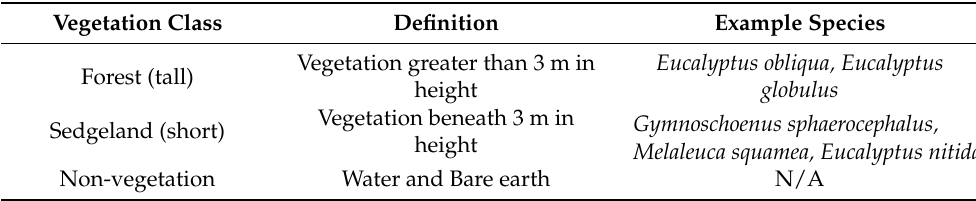
Table 1. Descriptions of vegetation classification.